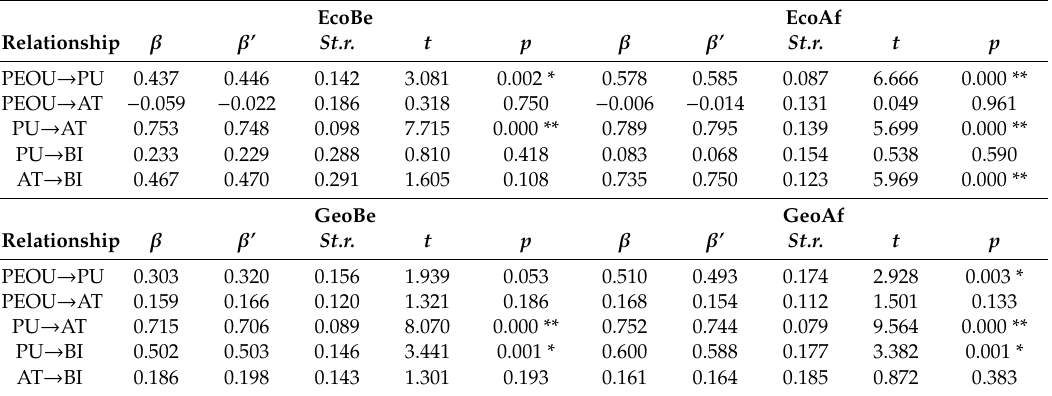
Table 6. Results of structural model analysis